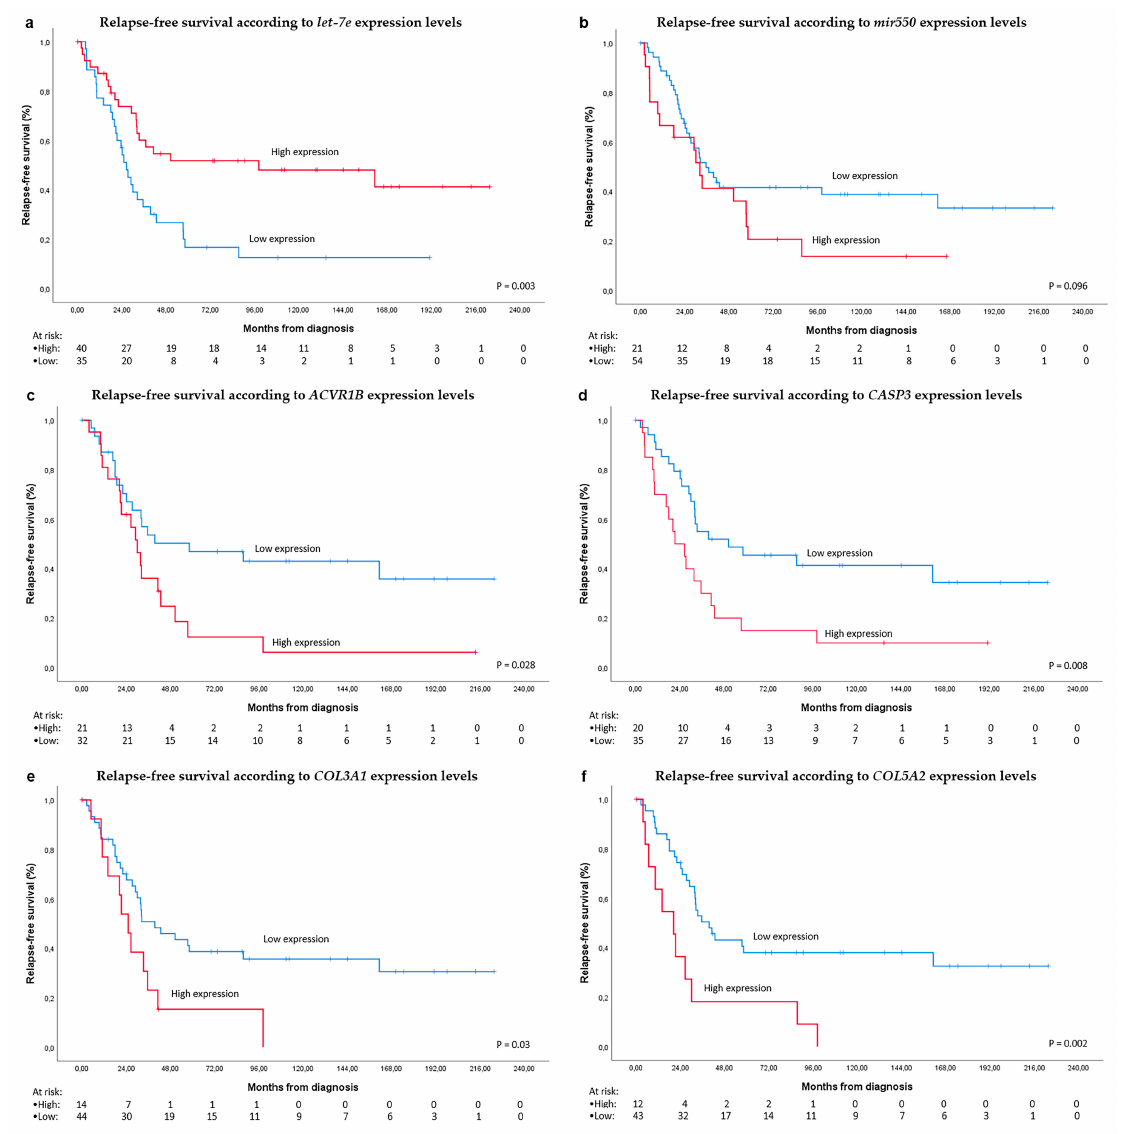
Figure 3. Survival analyses. ( a ) relapse-free survival (RFS) according to let-7e expression levels in the small intestine validation set; ( b ). RFS according to MIR550 expression levels; ( c ) RFS according to ACVR1B expression levels; ( d ) RFS according to CASP3 expression levels; ( e ) RFS according to COL3A1 expression levels; ( f ) RFS according to COL5A2 expression levels. Cuto ff points were calculated with the ROC curve, separating into High and Low expression groups, when the expression levels were above or below the cuto ff ,